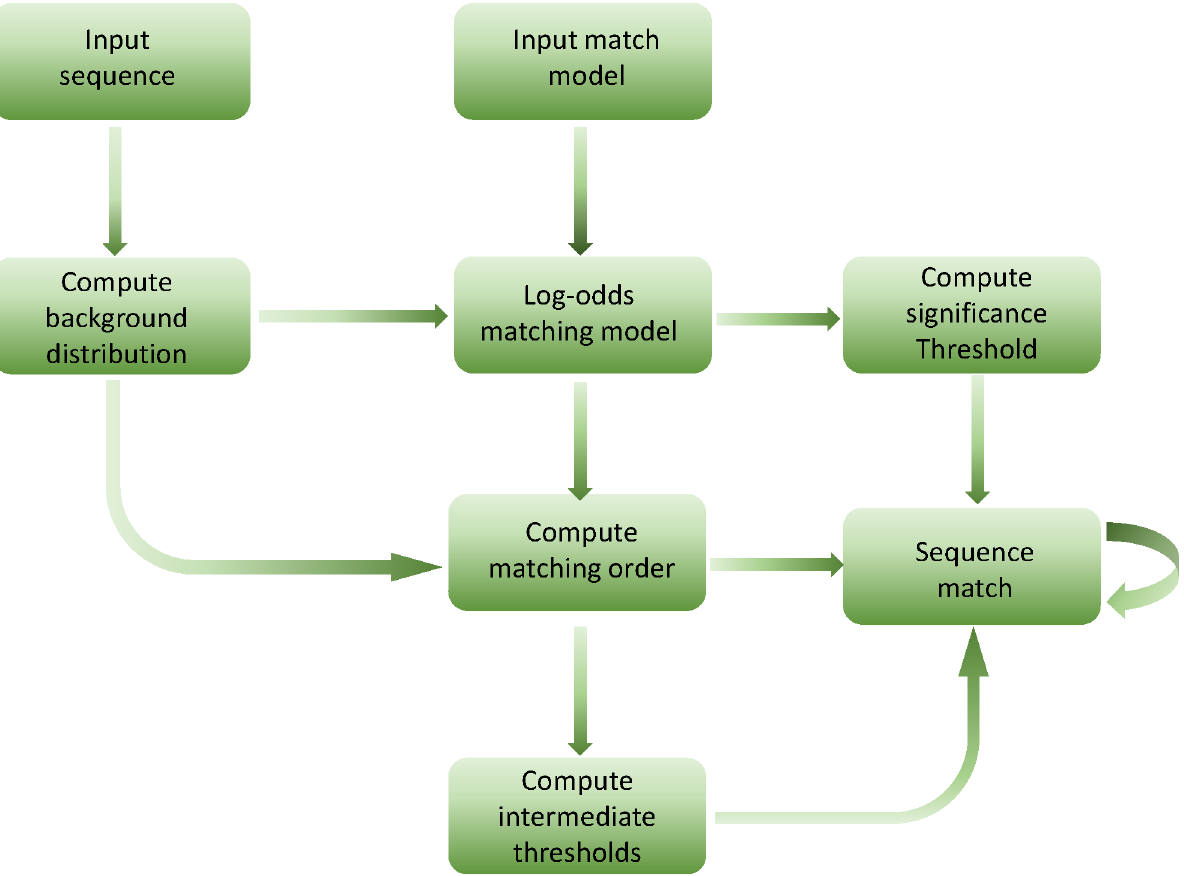
Fig 1. Overview of faster lookahead scoring algorithm with main